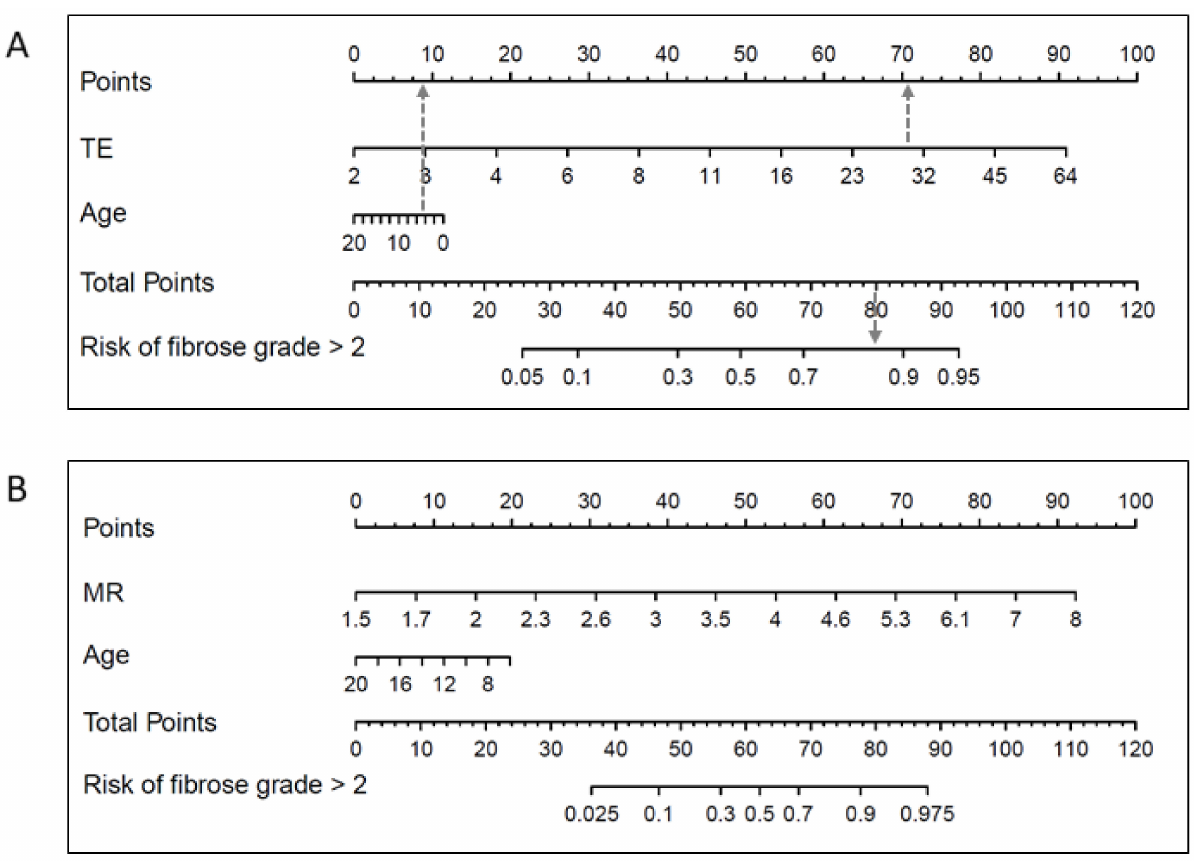
Figure 3. Receiver operating characteristics curves for the multiple imputation models.